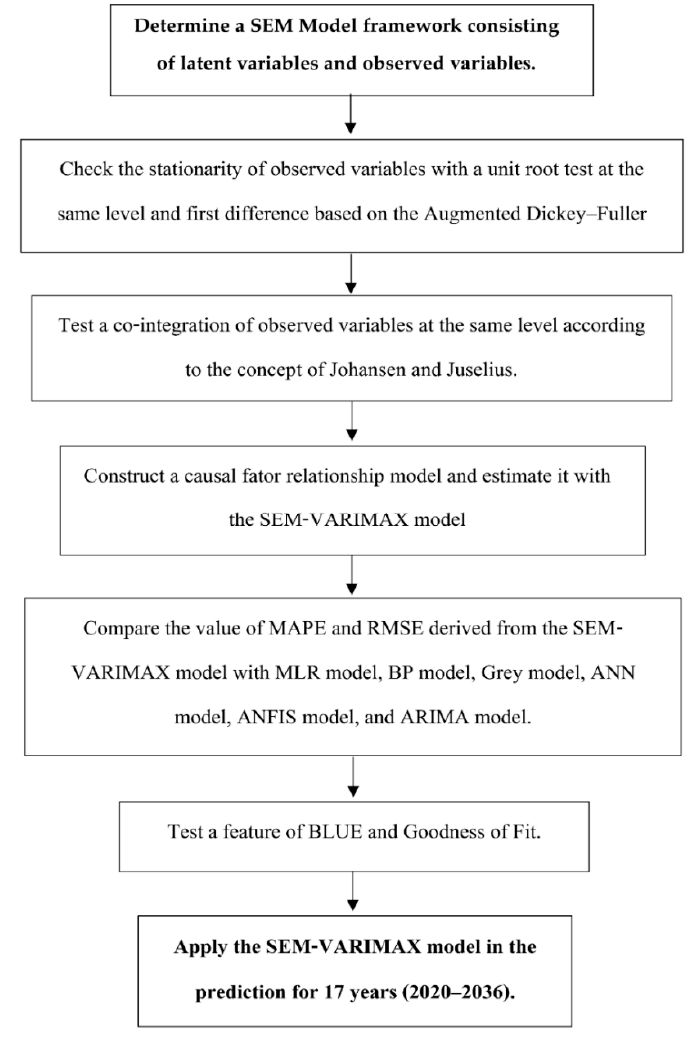
Figure 1. The flowchart of the structural equation modeling/vector autoregressive model with exogenous variables (SEM-VARIMAX) model.